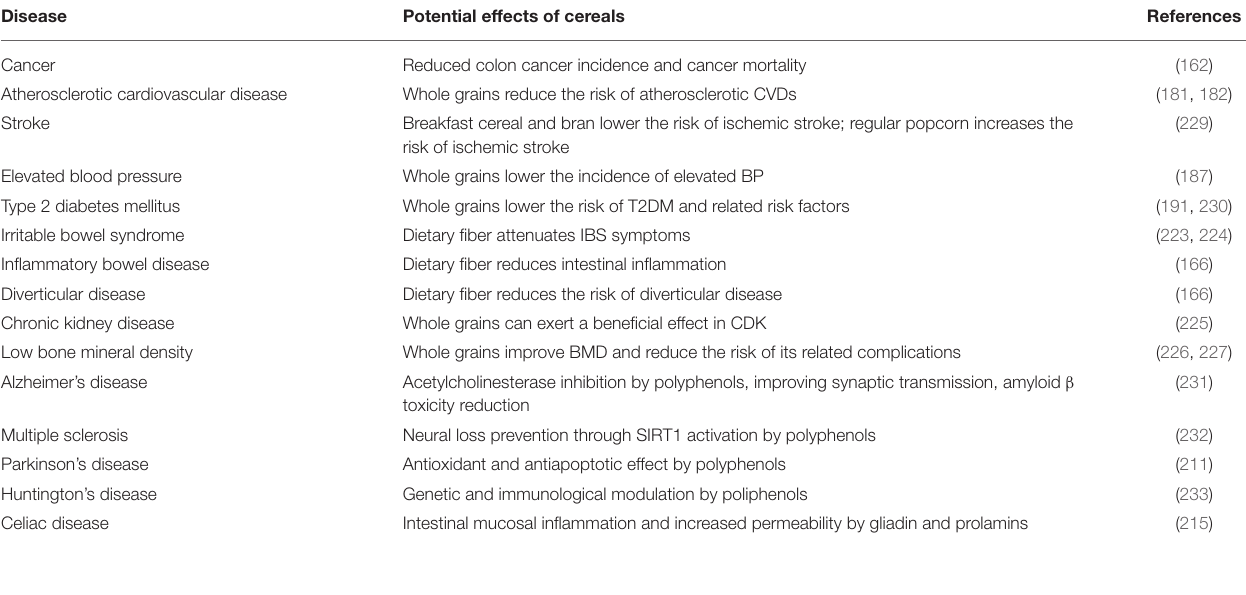
TABLE 4 | Potential effects of whole grains on diseases.